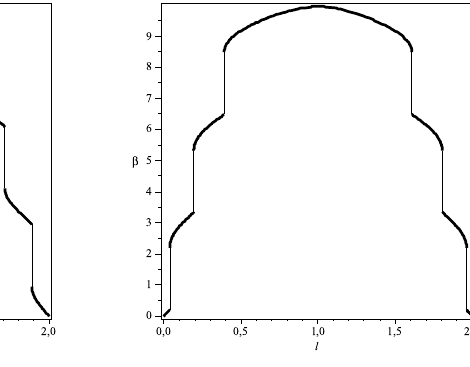
Figure 4. Stationary solution β s ( l ) at ωτ = 15 in the case of direct function.